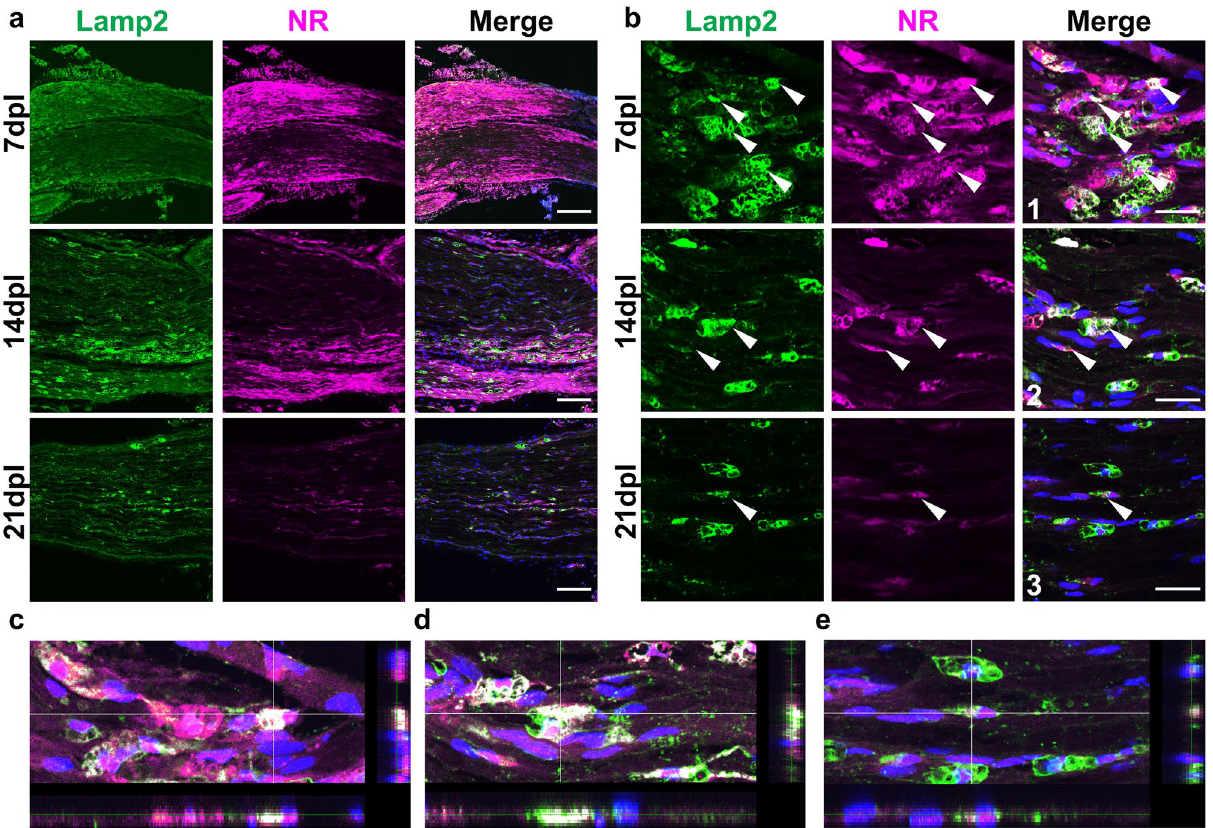
Figure 8. Neutral red (NR) colocalized with Lamp2-positive lysosome of cells in demyelinated lesions. ( a ) Representative confocal images of NR (magenta) and immunofluorescence staining for lysosomes labeled with anti-Lamp2 (green) at low ( a ) and high ( b ) magnification in areas with lysophosphatidylcholine injection at 7, 14 and 21 dpl (n = 3 mice per timepoint examined). Lamp2-positive lysosome colocalized with neutral red at 7 ( c ), 14 ( d ) and 21 ( e ) dpl ( b , arrowhead). Overlay of z-stack images with vertical (right) and horizontal (bottom) cross-sections are shown ( b1–3 : z-stack images of Merge). Nuclei were counterstained with Hoechst (blue). Scale bar, 50 µm ( a ) and 20 µm ( b ). z-stack images were analysed using Olympus Fluoview FV-ASW version 1.7, https:// www. olymp us- lifes cience.